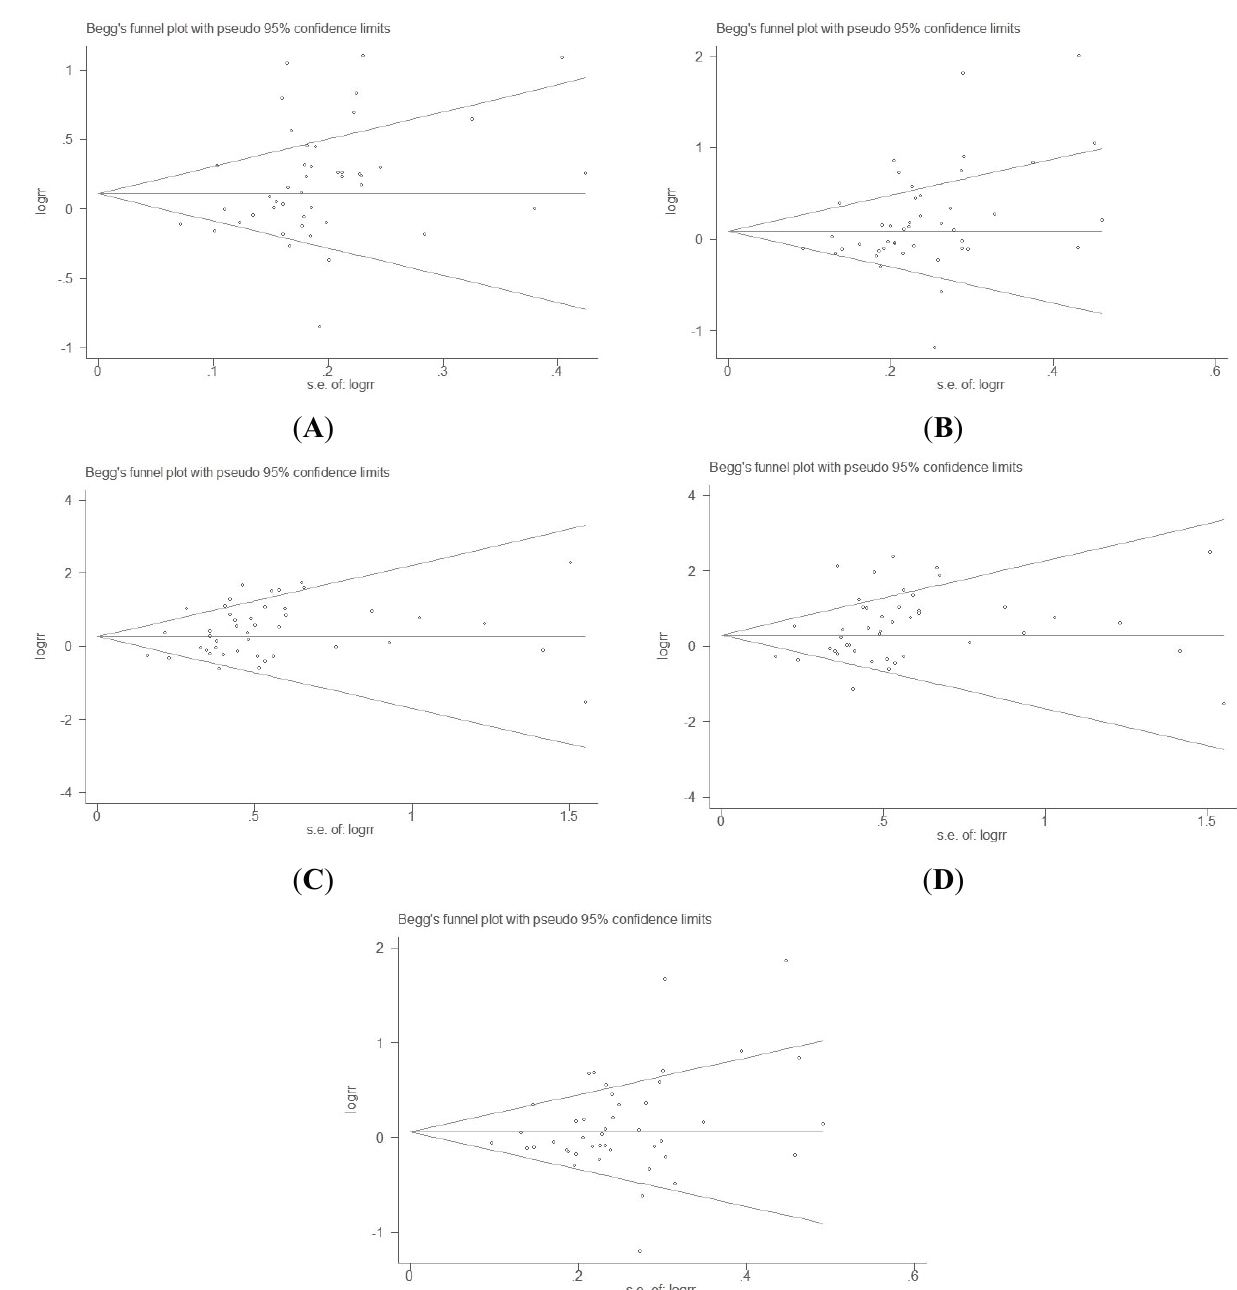
Figure 3. Funnel plots for ADIPOQ gene +45T>G polymorphism and T2DM risk in different genetic model. ( A ) Allelic model: G vs. T; ( B ) Dominant model: GG+GT vs. TT; ( C ) Recessive model: GG vs. GT+TT; ( D ) Homozygous model: GG vs. TT; and ( E ) Heterozygous model: GT vs.